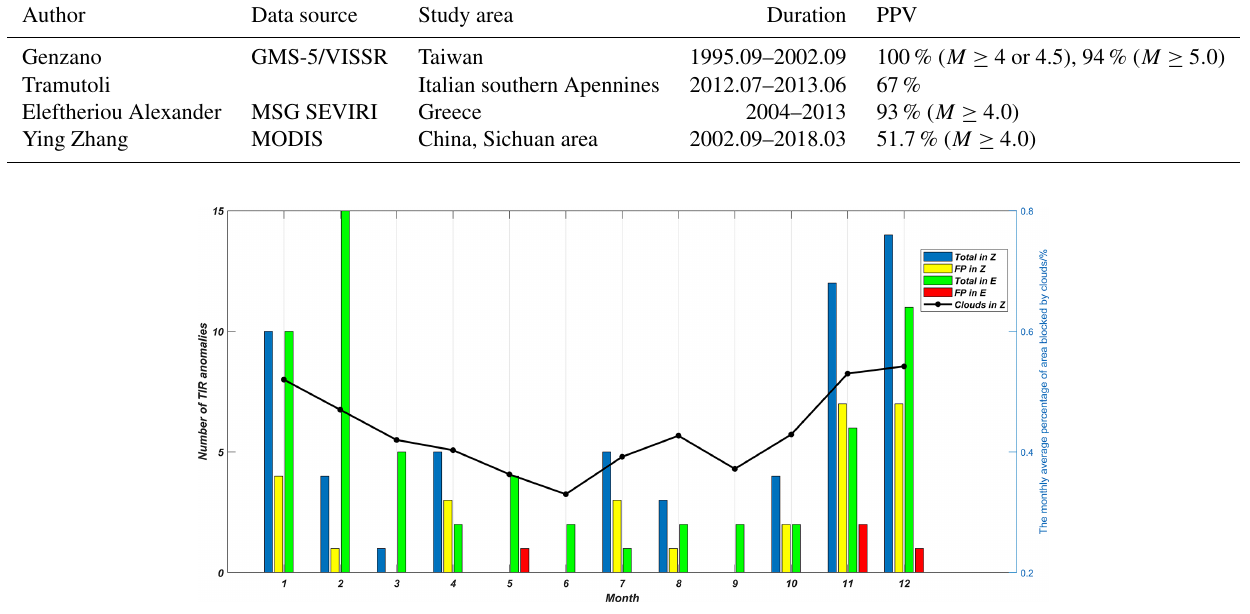
Figure 11. The monthly average percentage of the area not blocked by clouds in Zhang’s study region, i.e., that of this study. The bar chart presents the numbers of various types of TIR anomaly. “Total in Z ” is the total number of TIR anomalies in this study; “FP in Z ” is the number of TIR anomalies that do not correspond to any earthquakes in this study; “Total in E ” is the total number of TIR anomalies in Eleftheriou’s study; “FP in E ” is the number of TIR anomalies that do not correspond to any earthquakes in Eleftheriou’s